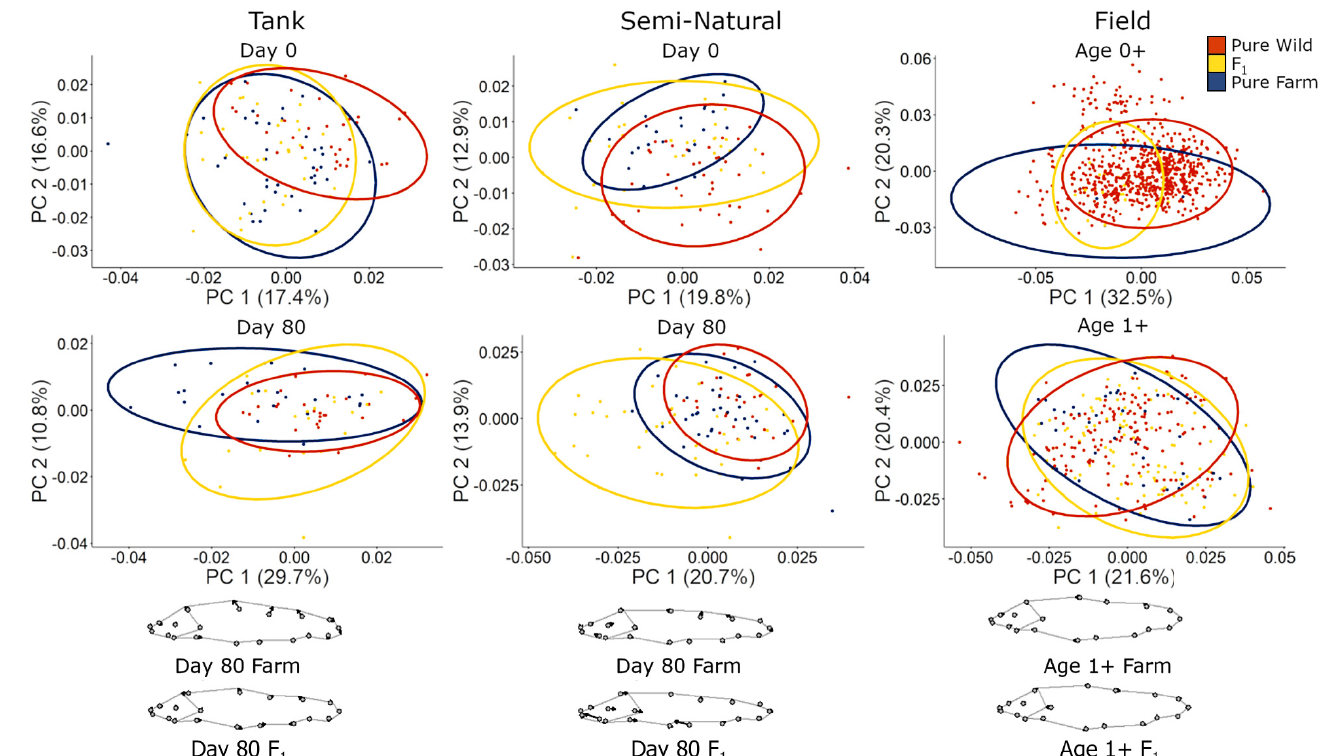
Fig. 2. Principal component analysis of landmarks after Procrustes alignment with 95% confidence ellipsis for each cross type. Experimental condition is noted above each panel, and the age group is on the x -axis. For the common garden experiment, shape is shown for Day 0 (start) and Day 80 (end) post yolk absorption. In the field component, juveniles aged 0+ (young of year) and 1+ were sampled from 18 locations (Fig. 1, Table S1). Relative differences in mean shape are also shown for the